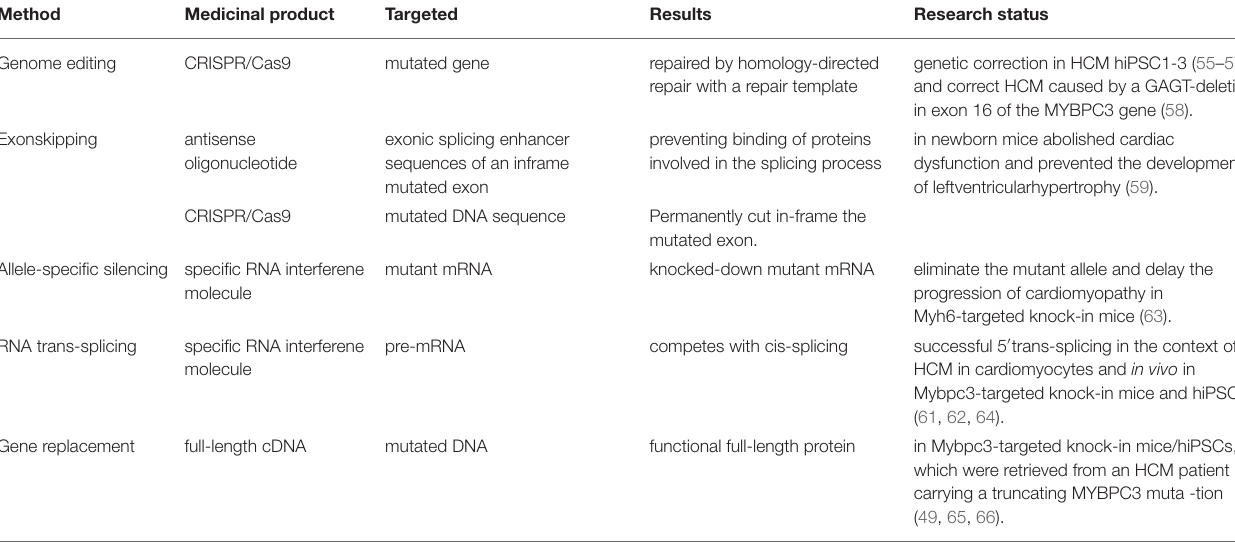
TABLE 4 | Table for the gene